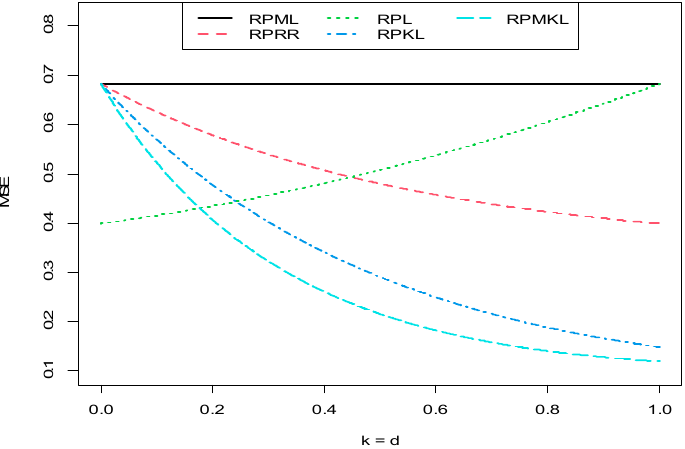
Figure 6. MSE values of the robust estimators against k and d of the Somerville Lake data.